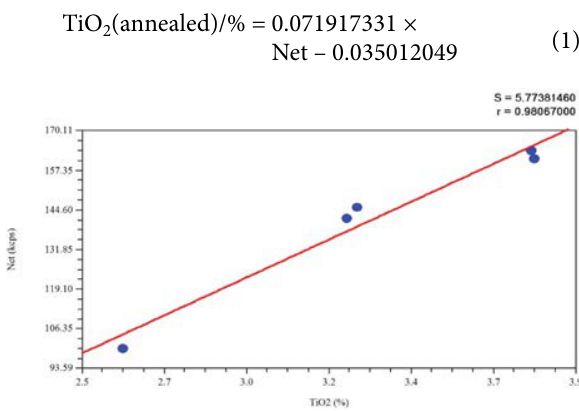
Figure 10. Calibration curve for the beads prepared by pressing